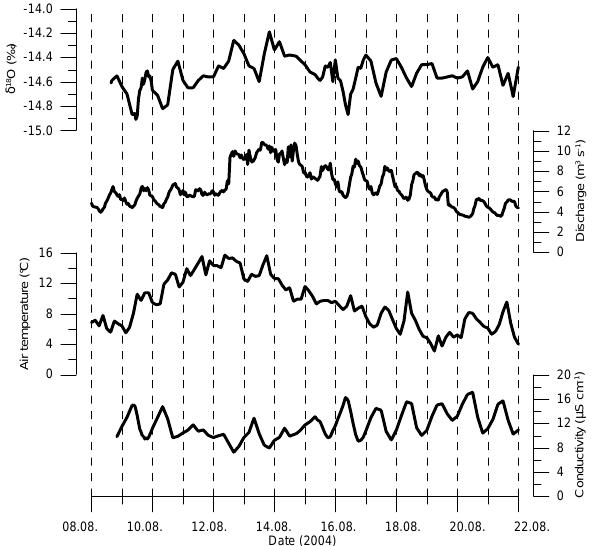
Figure 3. Time series of δ 18 O, discharge, air temperature and elec- tric conductivity in meltwater draining Mittivakkat Gletscher during the period 8–21 August 2004.